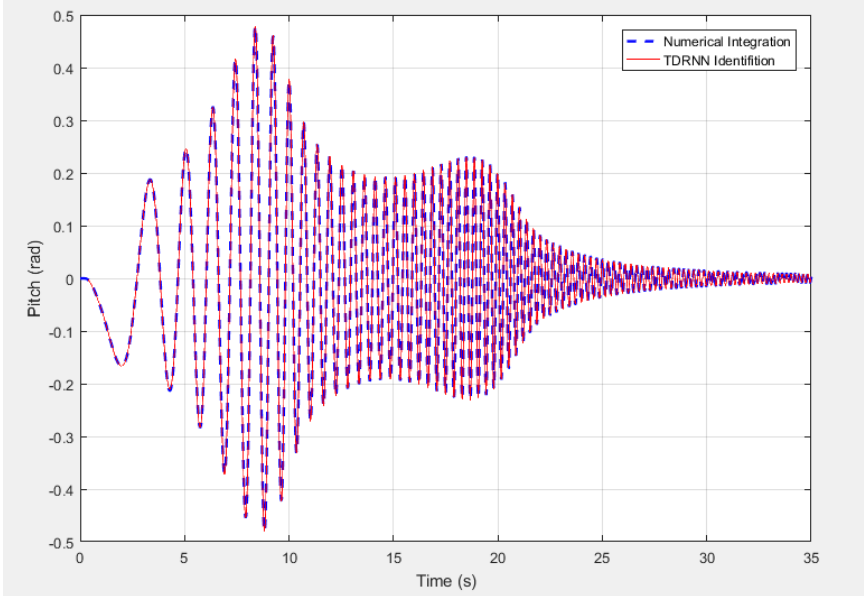
Figure 5. Response of chirp input signal.